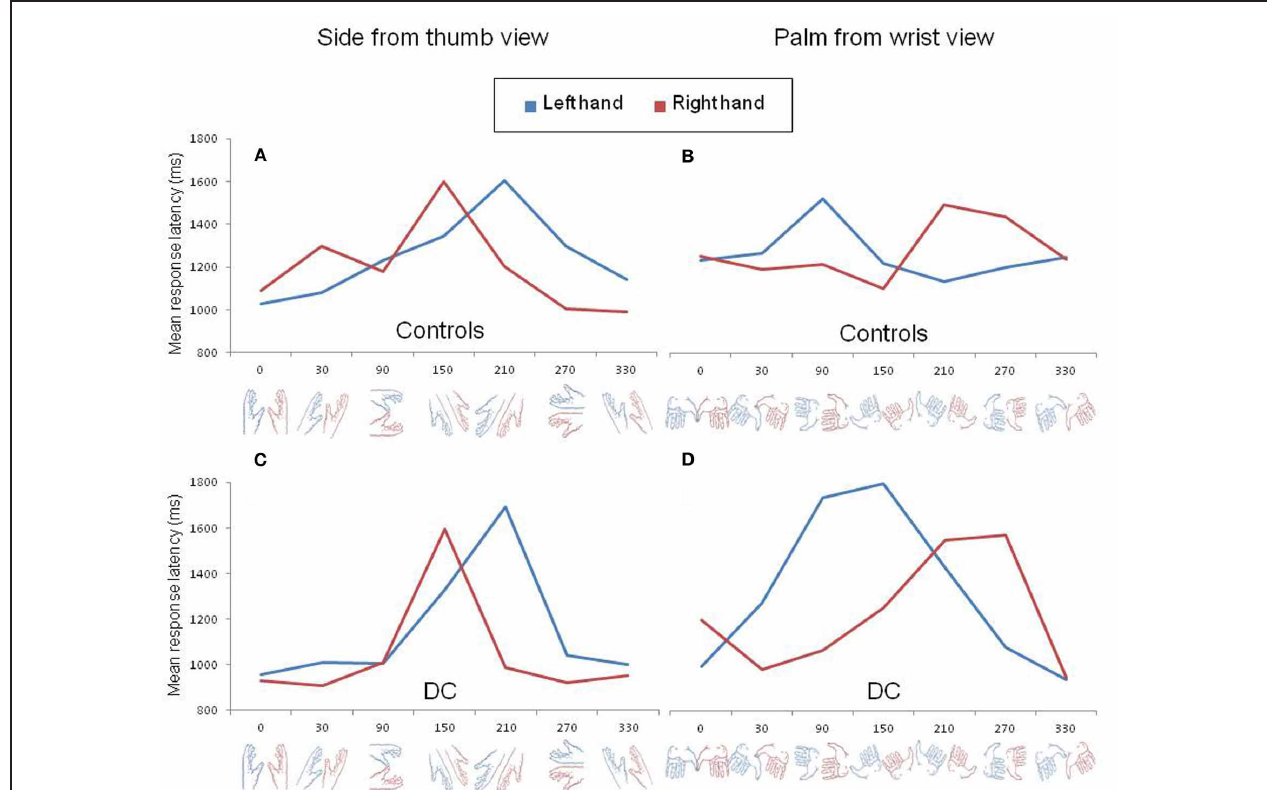
FIGURE 2 | Mean response latency for left (blue) and right (red) hand drawings rotated clockwise by steps of 60 ◦ viewed from the side (A,C) and from the wrist (B,D). The pattern of response latency in control participants and DC are shown in the upper ( A,B ) and lower ( C,D ) panels, respectively.